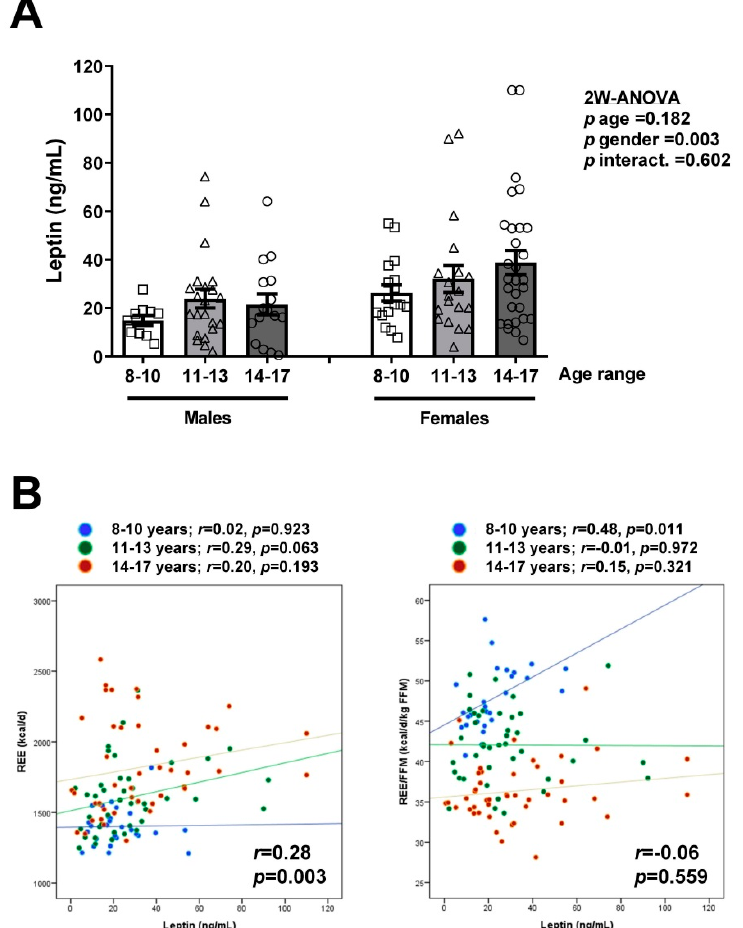
Figure 5. ( A ) Comparison of serum leptin concentrations in the subsample of children and adolescents ( n = 113) segregated by gender and age groups (8–10, 11–13, and 14–17 years). Values are means ± SEM. Differences between groups were analyzed by two-way ANOVA (age × gender). ( B ) Scatter diagrams showing the correlations of serum leptin levels with REE (left) and REE/FFM (right) segregated by age groups (8–10, 11–13 and 14–17 years). Pearson’s correlation coefficient ( r ) and p values are indicated.